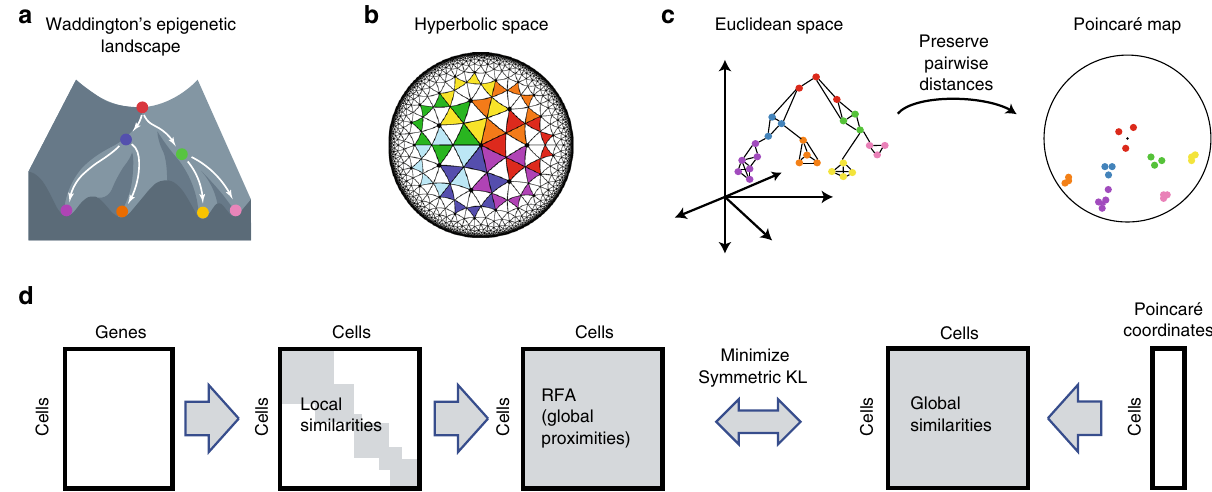
Fig. 1 Poincaré maps discover hierarchies and branching processes. a Our goal is to recover cell developmental processes, depicted here on the Waddington's epigenetic landscape. b Poincaré disks provide a natural geometry to preserve hierarchical structures and pairwise similarities in two dimensions. Poincaré disks grow as we approach their boundary: all the triangles depicted in the fi gure are of equal size. c Poincaré maps fi rst estimate geodesic distances, computed from a connected k -nearest-neighbor graph. Second, they compute two-dimensional hyperbolic embeddings that preserve these similarities. d Overview of Poincaré maps embedding procedure. From a given feature matrix, Poincaré maps fi rsts estimates local similarities based on a user speci fi ed local distance metric (Euclidean, cosine, etc.) and Gaussian kernel with a tunable parameter σ . Local similarities then used to compute global proximities on the dataset. By means of Riemanninan optimization of KL divergence, global proximities are aimed to be preserved through global distances in Poincaré